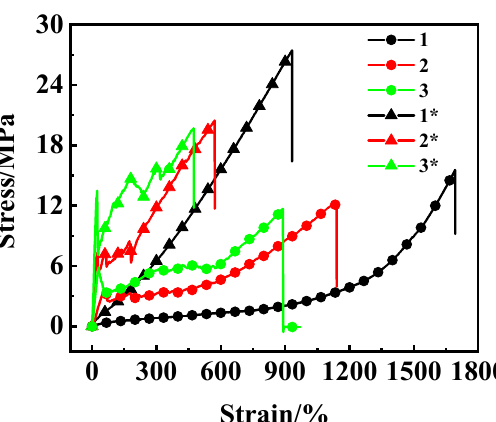
Figure 2. Stress–strain curves of NR and UHMWPE fiber/NR composites. The samples were mixed with the two-roll milling process, and the vulcanization process is 143 °C over 40 min.